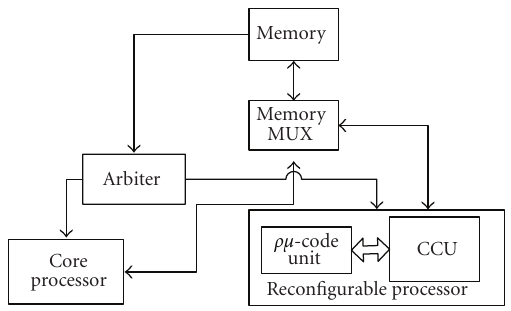
Figure 2: The machine organization of the Molen reconfigurable architecture. The architecture consists of a General Purpose Pro- cessor (GPP) and a Reconfigurable Processor (RP), which are coordinated by an